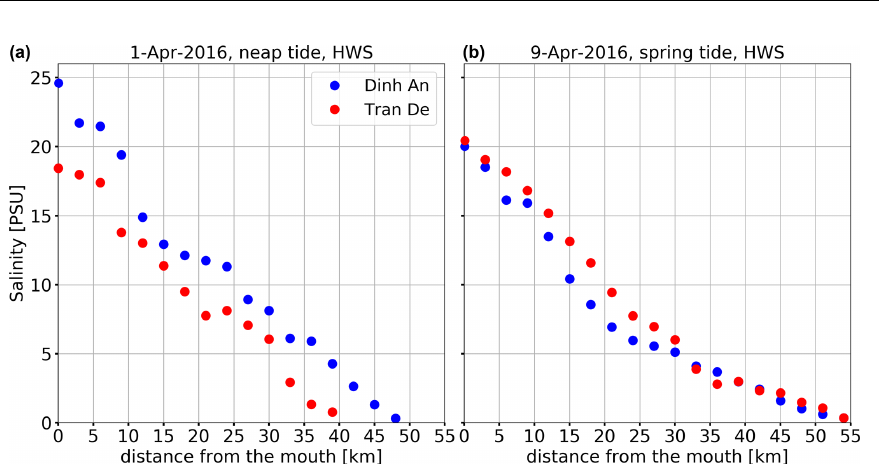
Figure 2. Observed salt intrusion at high water slack (HWS) during two consecutive neap (a) and spring (b) tides along the two lower Song Hau distributary channels (Dinh An and Tran De) during the 2016 VMD drought